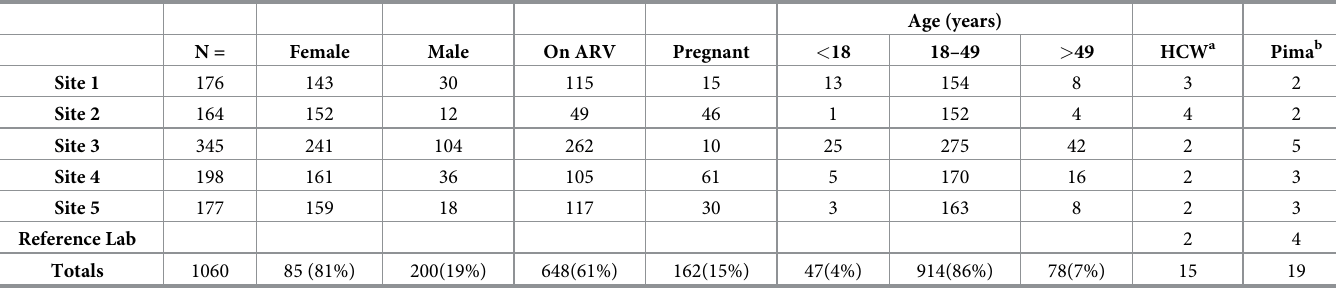
Table 1. Demographic of patients enrolled by healthcare site.